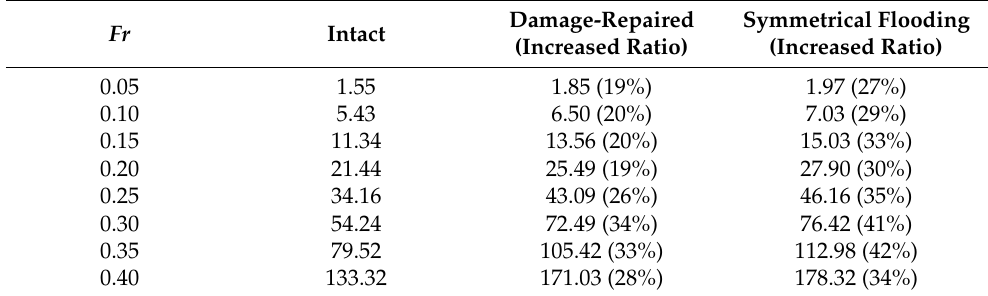
Table 10. The comparison of total resistance in intact, damage-repaired and symmetrical flooding cases at different forward speeds (unit: